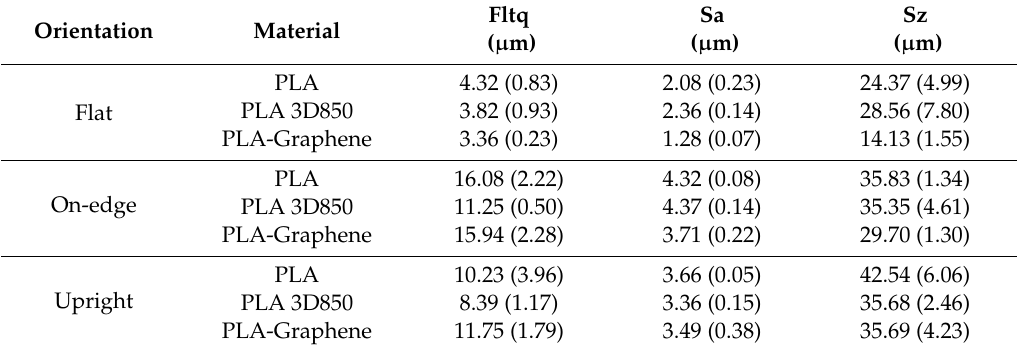
Table 7. Average surface texture results of PLA, PLA 3D850 and PLA-Graphene samples as a function of build orientation and the type of materials. Standard deviation is depicted in